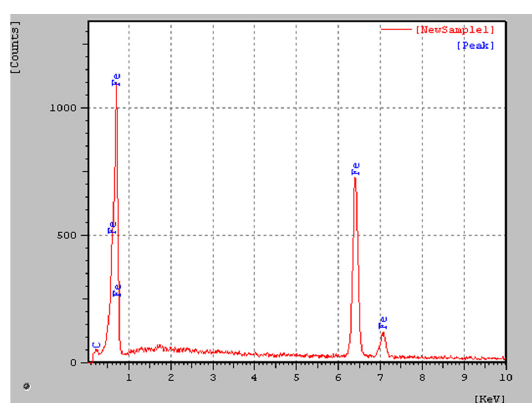
Figure 13. EDS analysis of uncoated diamond in point 03 of Figure 10.